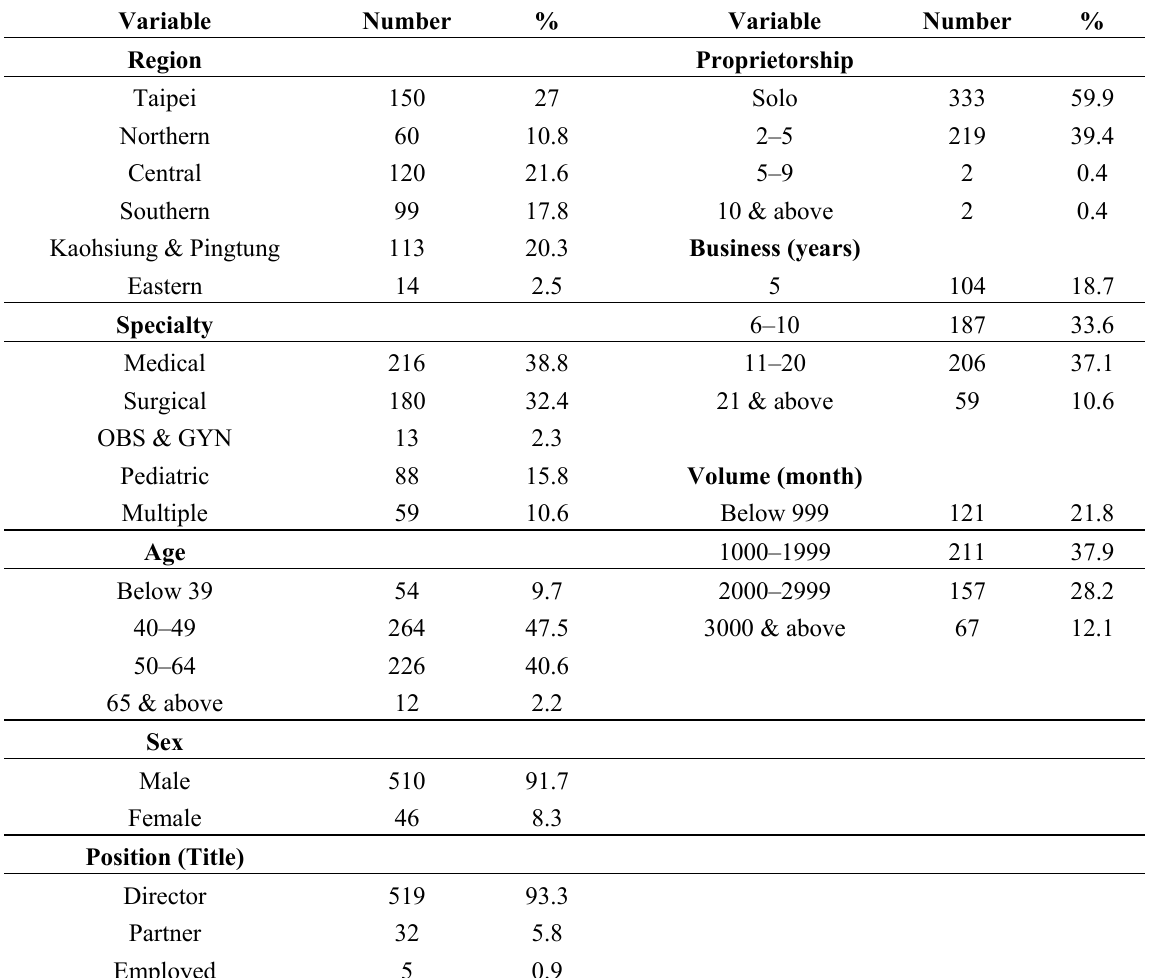
Table 1. Demographic data of